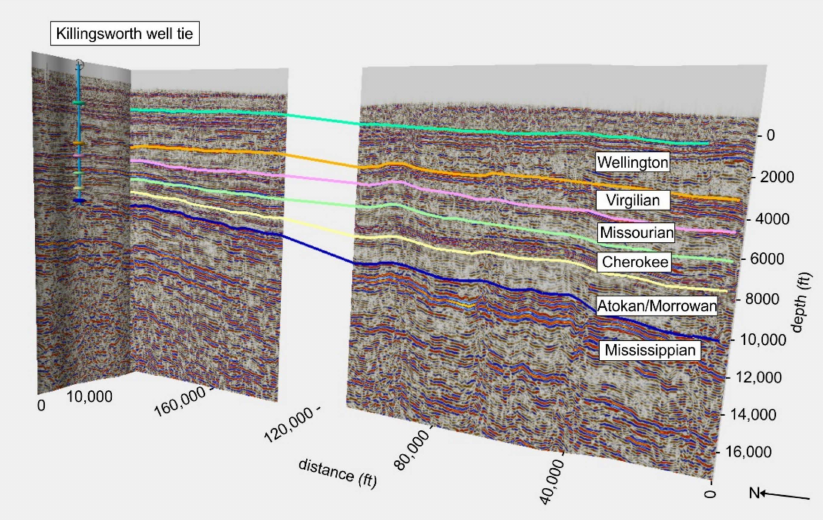
Figure 4. Interpretation of seismic lines DC-NEP-10 (short east–west line) and DC-NEP-33 (north and south), and well-tie with the Killingsworth well (light blue). Locations of lines and Killingsworth well shown in Figure 2. The Atokan/Morrowan formations are mostly transparent, and their boundaries cannot be resolved in these data. The Missourian Kansas City Group and Late Devonian-Early Mississippian Woodford shale are interpreted in the 3D seismic data (Figure 5). No seismically resolvable faults are observed on the 2D seismic lines in the Atokan or Morrowan